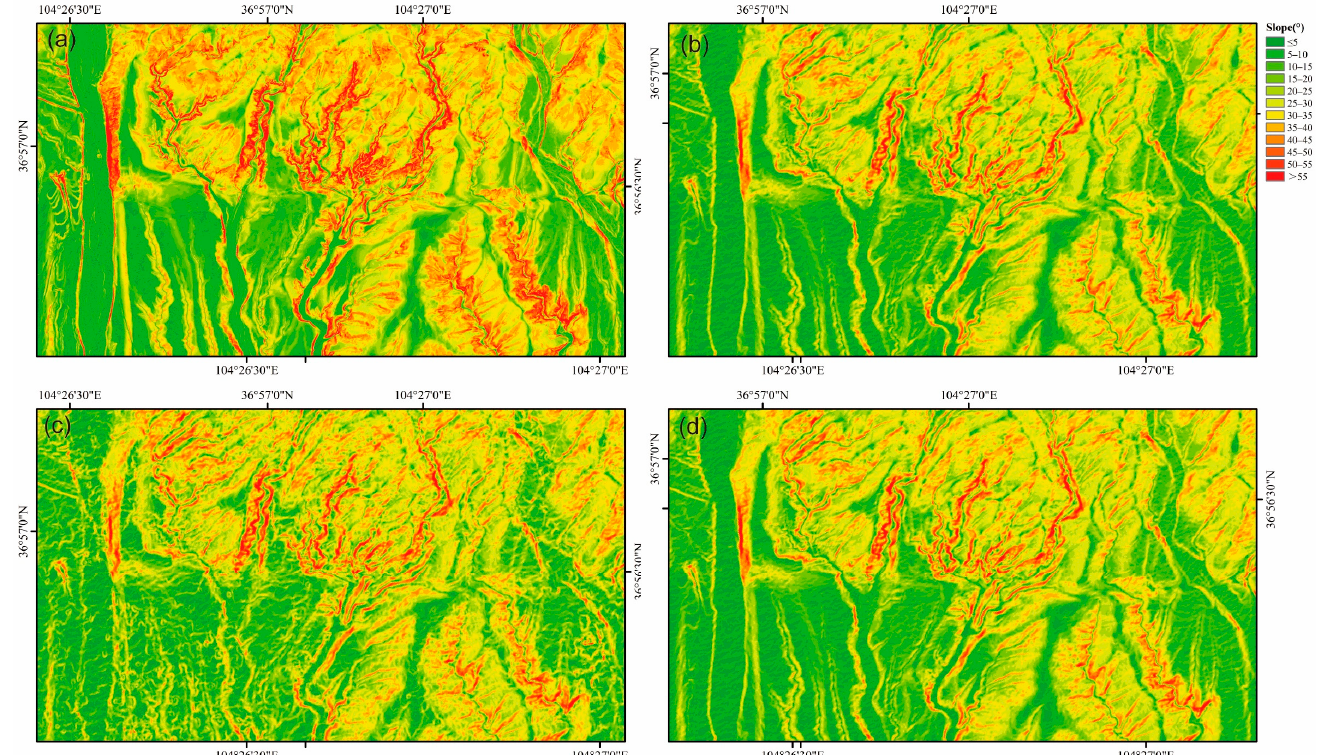
Figure 9. The distribution of the slope of the terrain derived from ( a ) the airborne LiDAR DEM, ( b ) GF-7 DEM Method1 , ( c ) GF-7 DEM Method2 , and ( d ) GF-7 DEM Method3 .